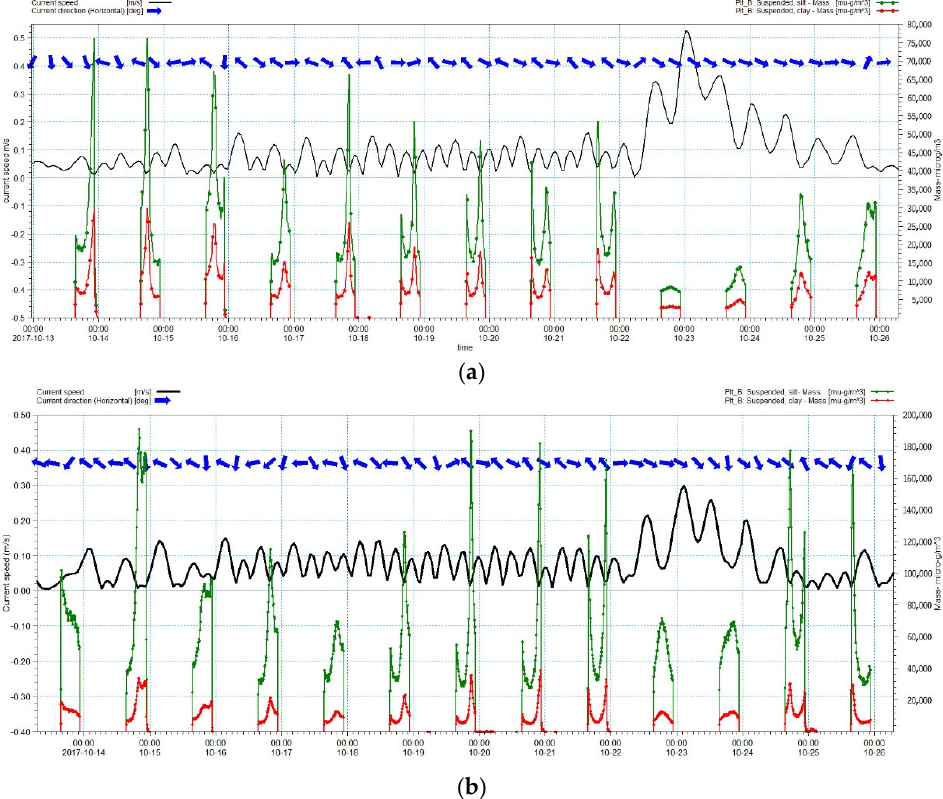
Figure 15. Time series (from 14 October 2017 to 26 October 2017) of suspended silt and clay concentration and current field (speed and direction) at the point where max concentration is detected during the simulation period as result by MIKE 3 PT module: ( a ) Plt A (depth 10.85 m; distance from source 2.8 m) and ( b ) Plt B (depth 20.85 m, distance from source 23.2 m).